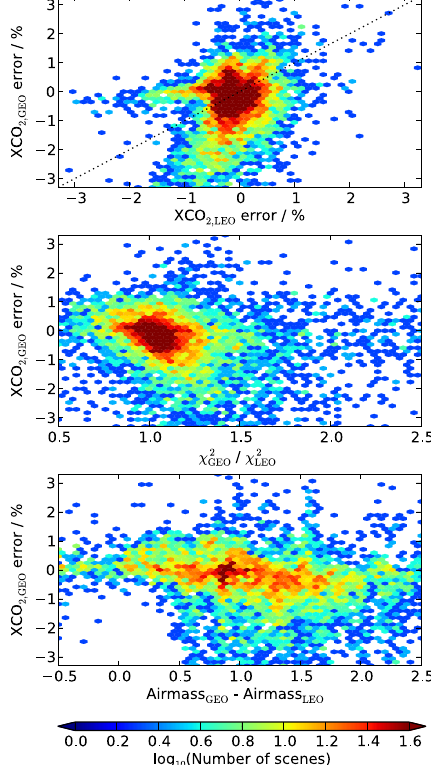
Figure 11. Relative aerosol- and cirrus-induced XCO 2 forward model errors (retrieved / true − 1) found by the GEO configuration as a function of the relative XCO 2 errors (retrieved / true − 1) in LEO configuration (upper panel), the ratio of χ 2 in GEO and LEO configuration (middle panel), and the difference between slant air mass in GEO and LEO configuration (lower panel). χ 2 is calculated , where the sum is of all detector pixels, i , y i, meas and y i, mod are the measured and the modeled radiance, σ i is the noise error, and N DFS is the number of degrees of freedom for signal. Slant air mass is calculated via 1 / cos(SZA) + 1 / cos(VZA) with solar zenith angle SZA and viewing zenith angle VZA. The color scale shows logarithmic occurrence. Note that the scale of residual XCO 2 errors is inflated by a factor 1.5 compared to Fig. 10 to cover the more challenging